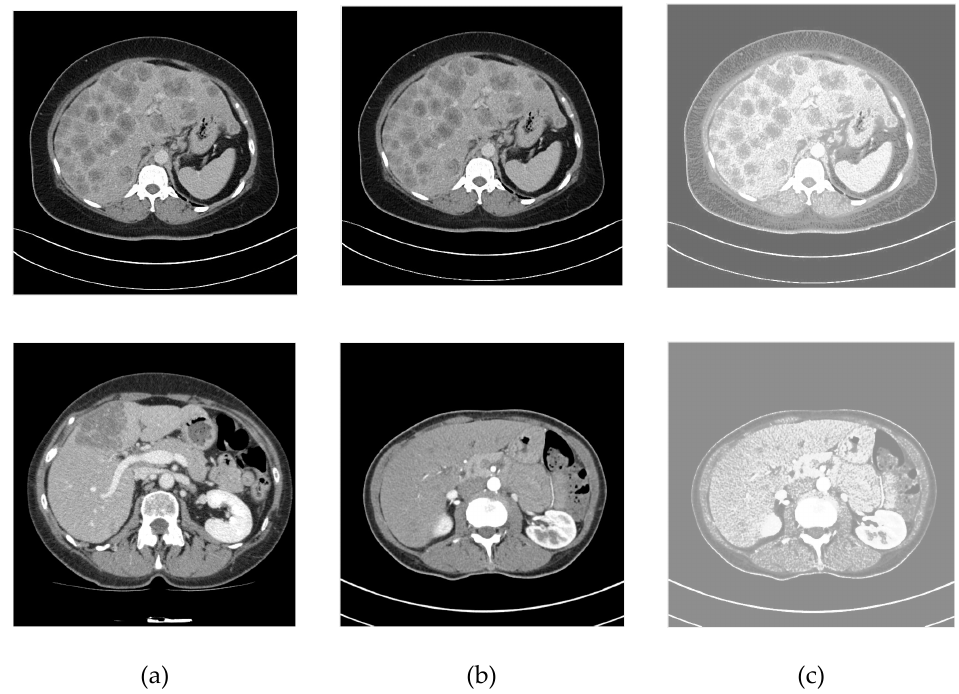
Figure 7. Preprocessing results of different cases: ( a ) original image, ( b ) median filtering result, and ( c ) histogram equalization result.